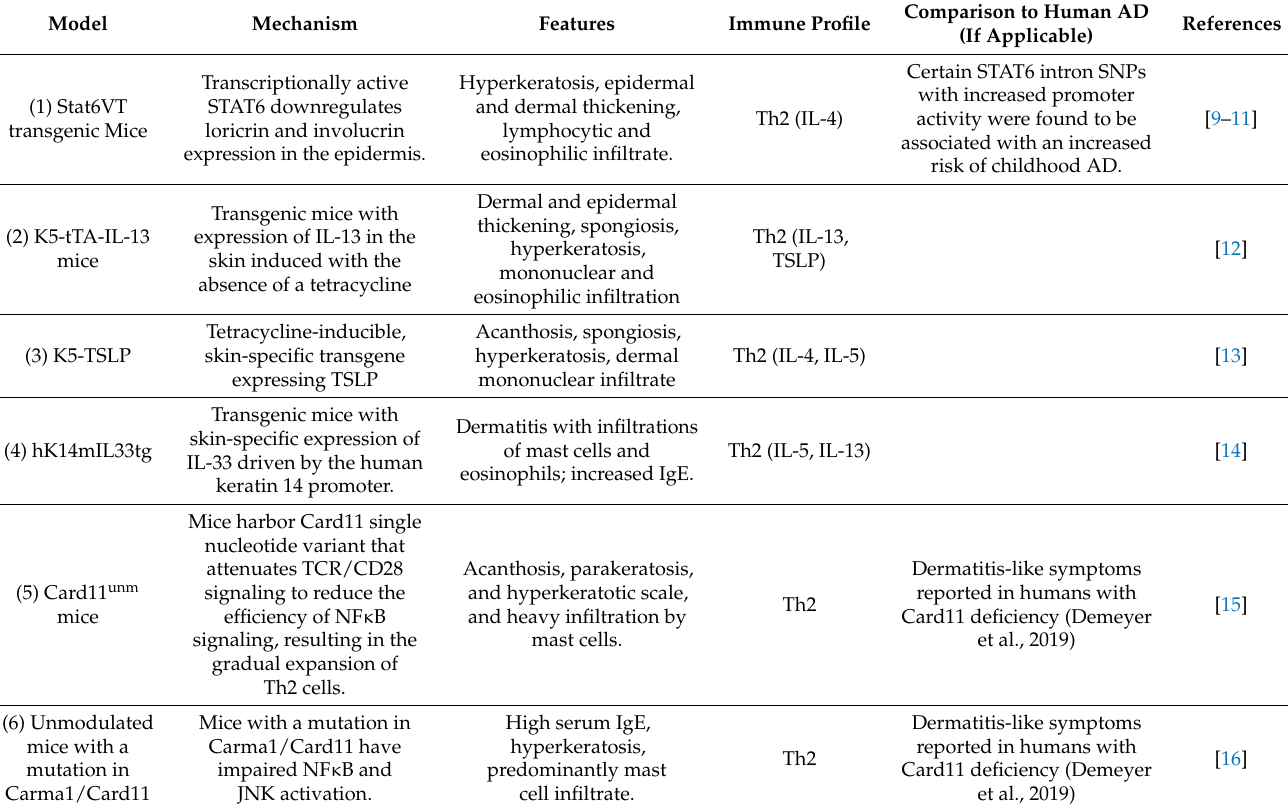
Table 1. Mouse models with Th2 and/or Th1